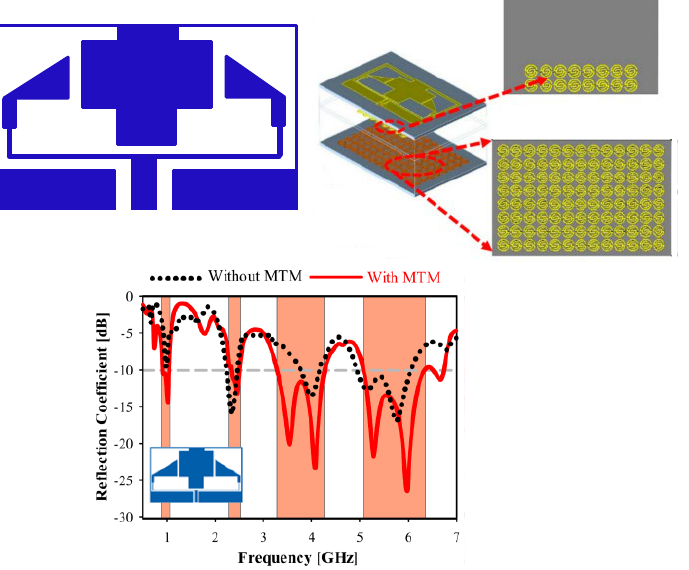
Figure 4. Schematics of the antenna in [27] with metamaterial to improve bandwidth. .( a ) Metamate- rial structure, ( c ) S-parameters of the antenna, ( c ) fabricated prototype, ( d ) S-parameter phase. Re- printed from Ref. [27].